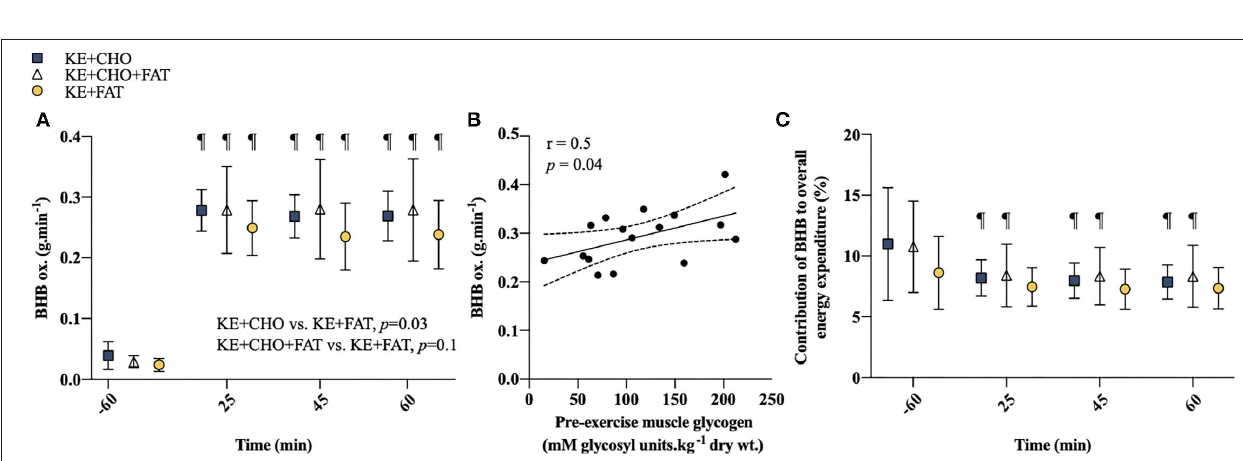
FIGURE 3 | β HB oxidation. (A) β HB oxidation rates at rest and during exercise. (B) Association between pre-exercise IMGLY and mean β HB oxidation rates during exercise. Limits represent 95% CI. (C) Contribution of β HB to overall energy expenditure at rest and during exercise. Significant post-hoc comparisons: ¶ = within group, vs. t = − 60min (fasted). Values = mean ±